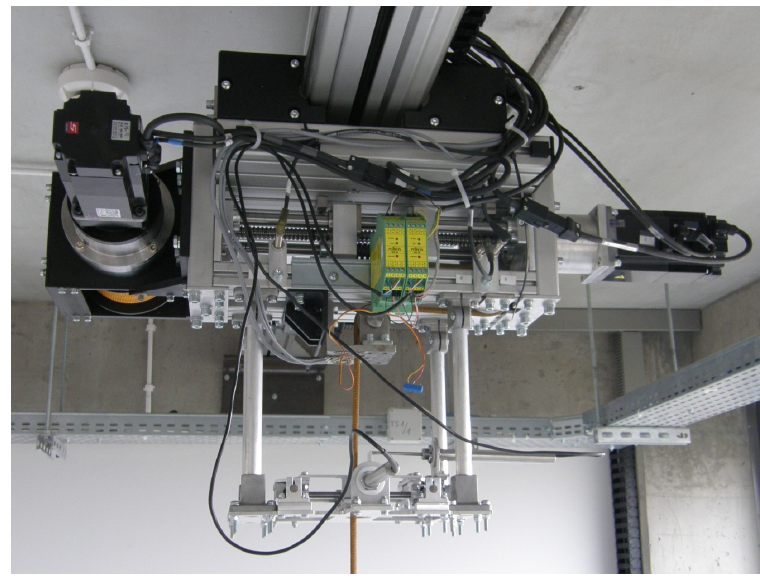
Figure 2. Considered body weight support system.